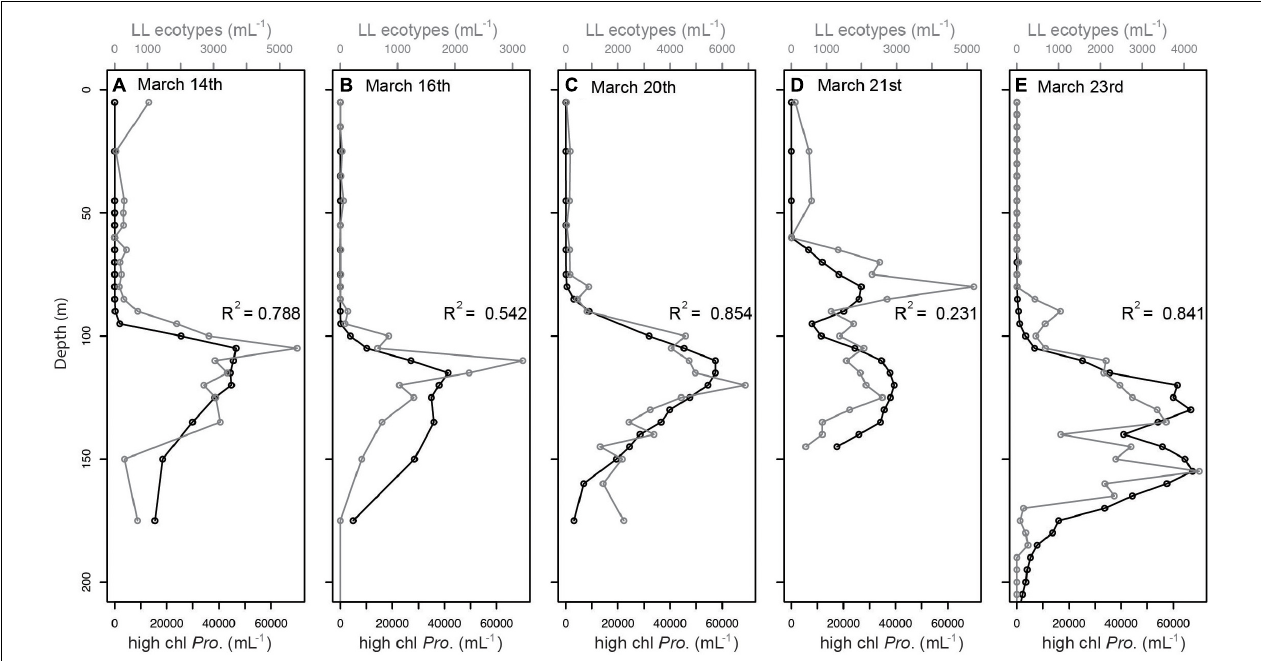
FIGURE 3 | Comparison of vertical profiles of Prochlorococcus LL ecotypes (eNATL and eSS120) across the two week time-course (A–E) , as measured by qPCR (black symbols) and “bright” (high chl. Pro .) Prochlorococcus cells as measured by flow cytometry (gray symbols) and defined in Supplementary Figure S1 . The relationship between these independent measurements on the same subpopulations of Prochlorococcus cells is indicated by the correlation values ( R 2 ) shown in each plot. Peak wind speeds and deepest mixing occurred on March 16th (B) and eased through the remaining time course. Similar patterns were observed over a year time-course at Station ALOHA ( Supplementary Figure S7 ). Comparison of “bright” and “dim” abundances over depth were presented previously in van den Engh et al.